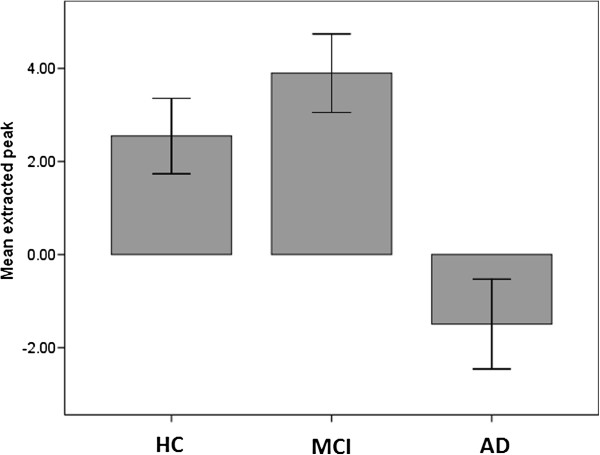
Between group activation differences for PHG/hippocampal cluster (error bars ± 1 SE).